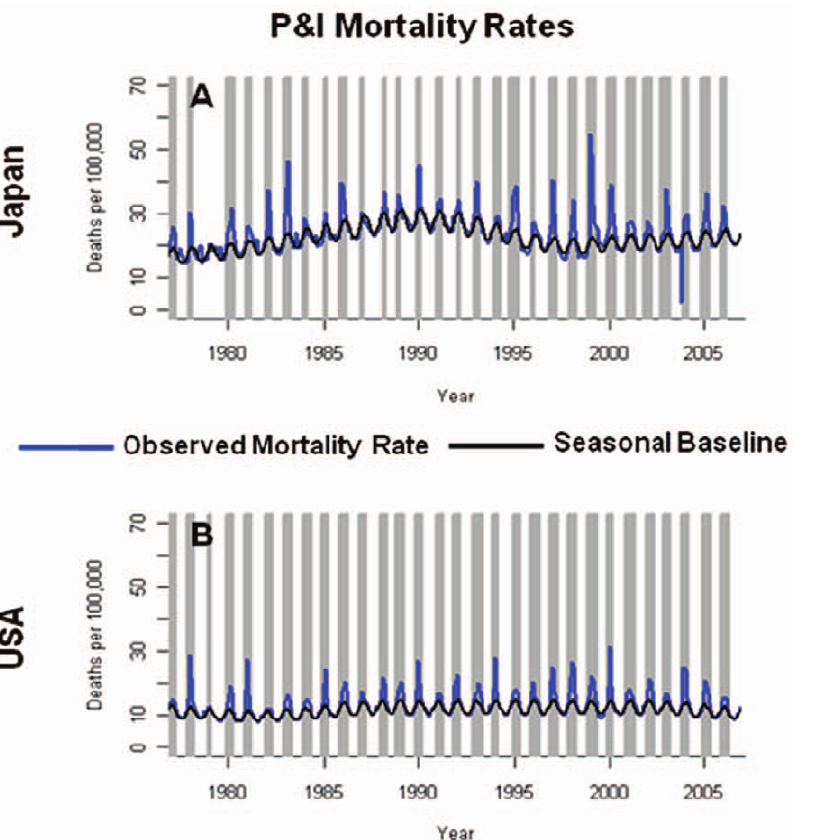
Figure 1. Pneumonia and influenza (P&I) mortality rates among the Japanese (A) and US (B) elderly, aged 65–89 years, Jan. 1977– Dec. 2006. Expected mortality rates in the absence of influenza virus circulation are shown in black, as determined by the Serfling seasonal baseline approach. Influenza epidemic months are highlighted in grey.